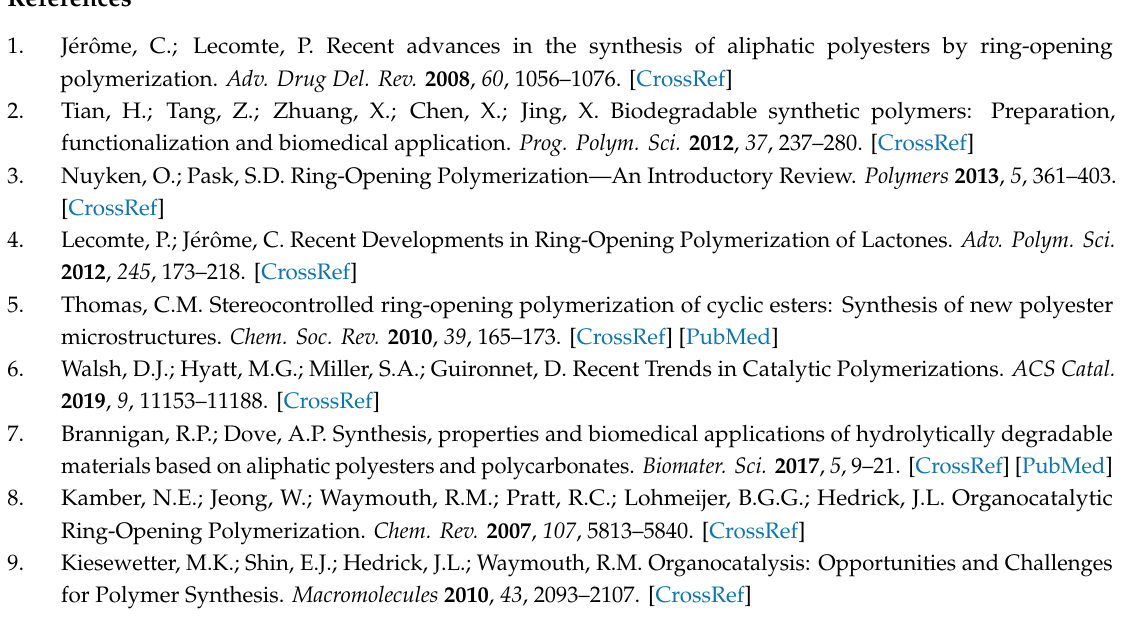
Figure S1: 1 H NMR spectrum of the reaction mixture of ε CL polymerization, catalyzed by 1 / BnOH (Table 1, Entry 7, ε CL / 1 / BnOH ratio 100:1:1), Figure S2: 1 H NMR spectrum of the reaction mixture of ε CL polymerization, catalyzed by 3 / BnOH (Table 1, Entry 12, ε CL / 3 / BnOH ratio 100:1:1), Figure S3: DSC curves (second heat) of PLLA obtained in the presence of 1 / BnOH (A) and 3 / BnOH (B) (Table 1, Entries 4 and 6, respectively), Figure S4: DSC curve (second heat) of l LA / ε CL copolymer obtained in the presence of 3 / BnOH at 1:1 l LA / ε CL ratio (Table 2, Entry 6), Figure S5: DSC curves (second heat) of l LA / ε CL copolymers obtained in the presence of 3 / BnOH at 1:5 l LA / ε CL ratio after 5 h (top) and 15 h (bottom) (Table 2, Entries 9c and 9d, respectively), Figure S6: Molecular structure of the complex 4 . The probability for thermal ellipsoids is set to the 50% level, Figure S7: 1 H NMR spectrum (CDCl 3 , 600 MHz) of l LA / ε CL copolymer obtained by transesterification of PLLA (Table 4, Entry 2, reprecipitated from MeOH), Figure S8: 13 C NMR spectrum (CDCl 3 , 151 MHz) of l LA / ε CL copolymer obtained by transesterification of PLLA (Table 4, Entry 2, reprecipitated from MeOH), Figure S9: DSC curves (second heat) of l LA / ε CL copolymers obtained in the presence of 3 / BnOH by transesterification of PLLA after 5 h (top) and 15 h (bottom) (Table 4, Entries 1 and 2, respectively), Figure S10: 1 H NMR spectrum (CDCl 3 , 600 MHz) of MeGL / ε CL copolymer (Table 4, Entry 3c, reprecipitated from MeOH), Figure S11: 13 C NMR spectrum (CDCl 3 , 151 MHz) of MeGL / ε CL copolymer (Table 4, Entry 3c, reprecipitated from MeOH), Figure S12: 1 H NMR spectrum (CDCl 3 , 600 MHz) of EtEP / ε CL copolymer (Table 4, Entry 5c), Figure S13: 13 C NMR spectrum (CDCl 3 , 151 MHz) of EtEP / ε CL copolymer (Table 4, Entry 5c), Figure S14: 31 P NMR spectra (CDCl 3 , 162 MHz) of EtEP / ε CL copolymerization probes after 1, 3 and 5 h (Table 4, Entries 5a–c), Figure S15: 1 H NMR spectrum (CDCl 3 , 400 MHz) of EtOEP / ε CL copolymer (Table 4, Entry 6c, reprecipitated from MeOH), Figure S17: 31 P NMR spectrum (CDCl 3 , 162 MHz) of EtOEP / ε CL copolymer (Table 4, Entry 6c, reprecipitated from MeOH), Table S1: Crystal data and structure refinement for 4 , Table S2: Bond lengths, Å; DFT calculations data: plots of the molecular geometries, energies and Cartesian coordinates for stationary points and transition states mentioned in the